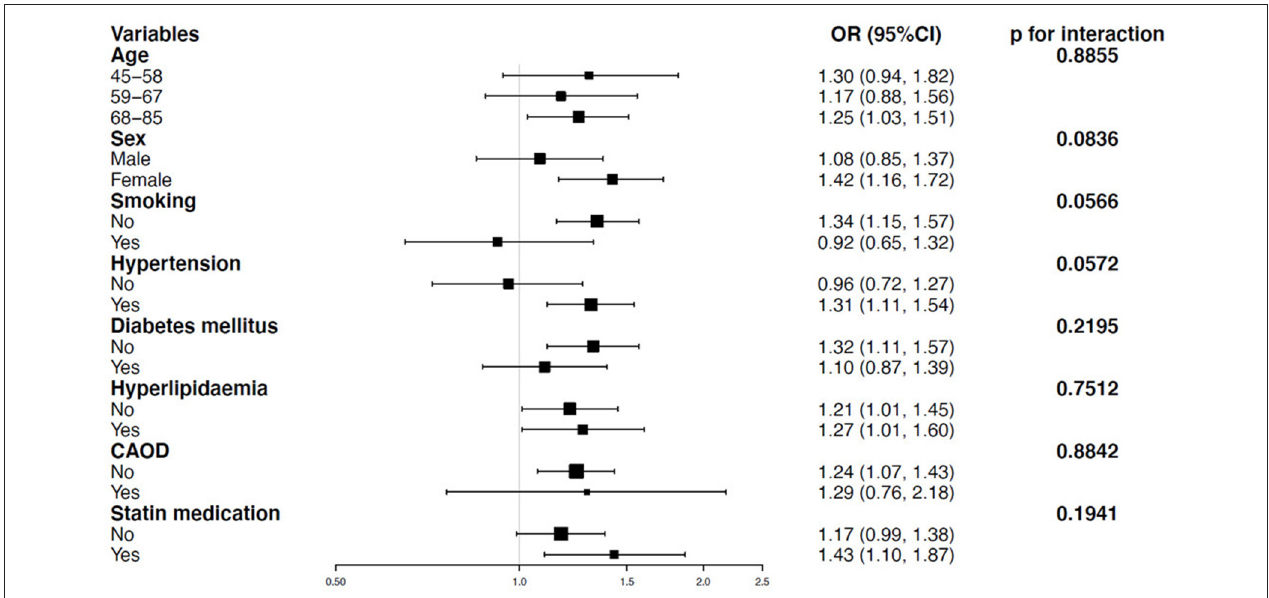
FIGURE 2 | Association between uric acid level and the presence of ICAS. The solid red and dashed blue lines reflect the estimated probability and 95% CI for the presence of ICAS, respectively, and were drawn using the generalized additive model. Adjusted for sex, age (years), hypertension, diabetes mellitus, hyperlipidemia, coronary artery occlusive disease (CAOD), statin medication, and fasting glucose level (g/dl). ICAS, intracranial arterial stenosis; CAOD, coronary artery occlusive.